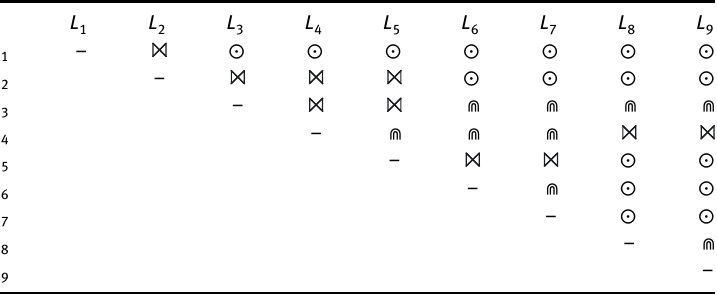
Table 1: The relation matrix of the RNA secondary structure shown in Figure 5. L 1